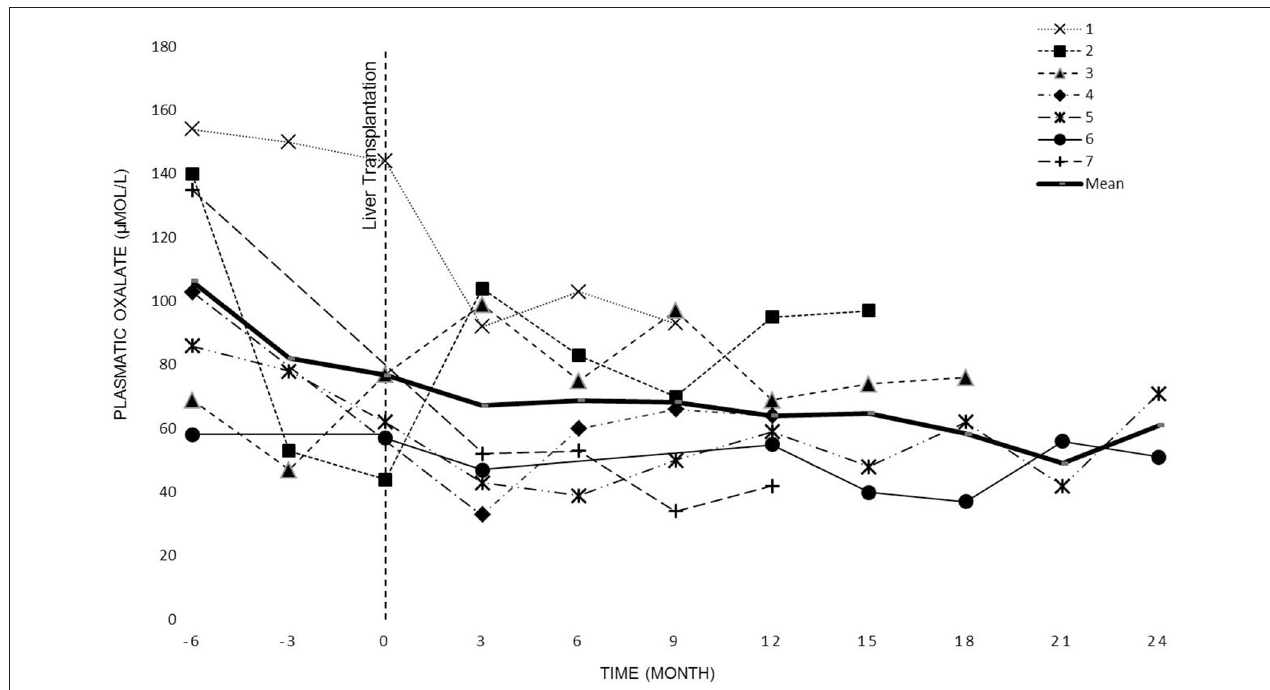
FIGURE 2 | Patient’s plasmatic oxalate evolution before KT.